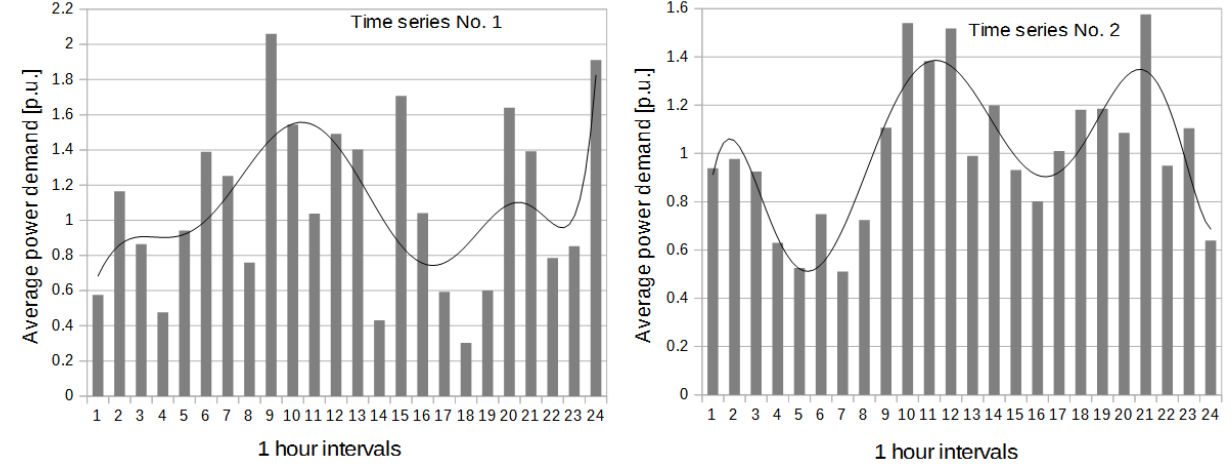
Figure 4. Daily variation of power demand in 1 h periods for both time series.